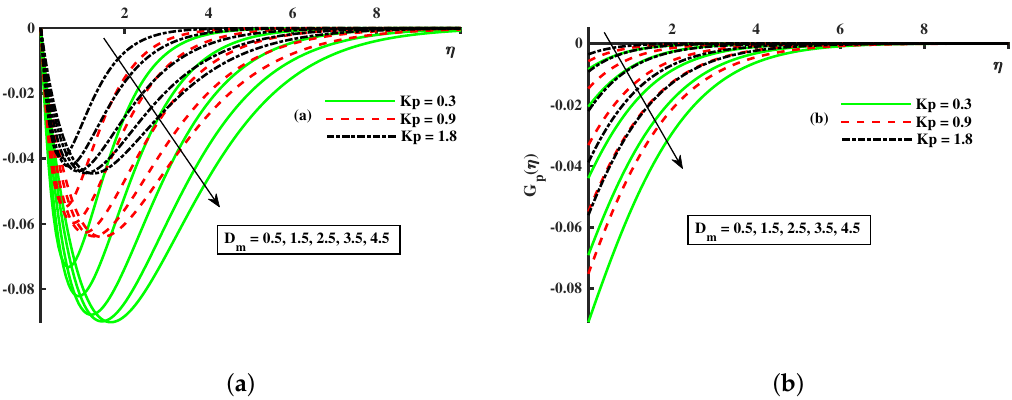
Figure 9. Fluctuation of Kp and D m on G ( η ) ( a ) and the effect of Kp and D m on G p ( η ) ( b ).